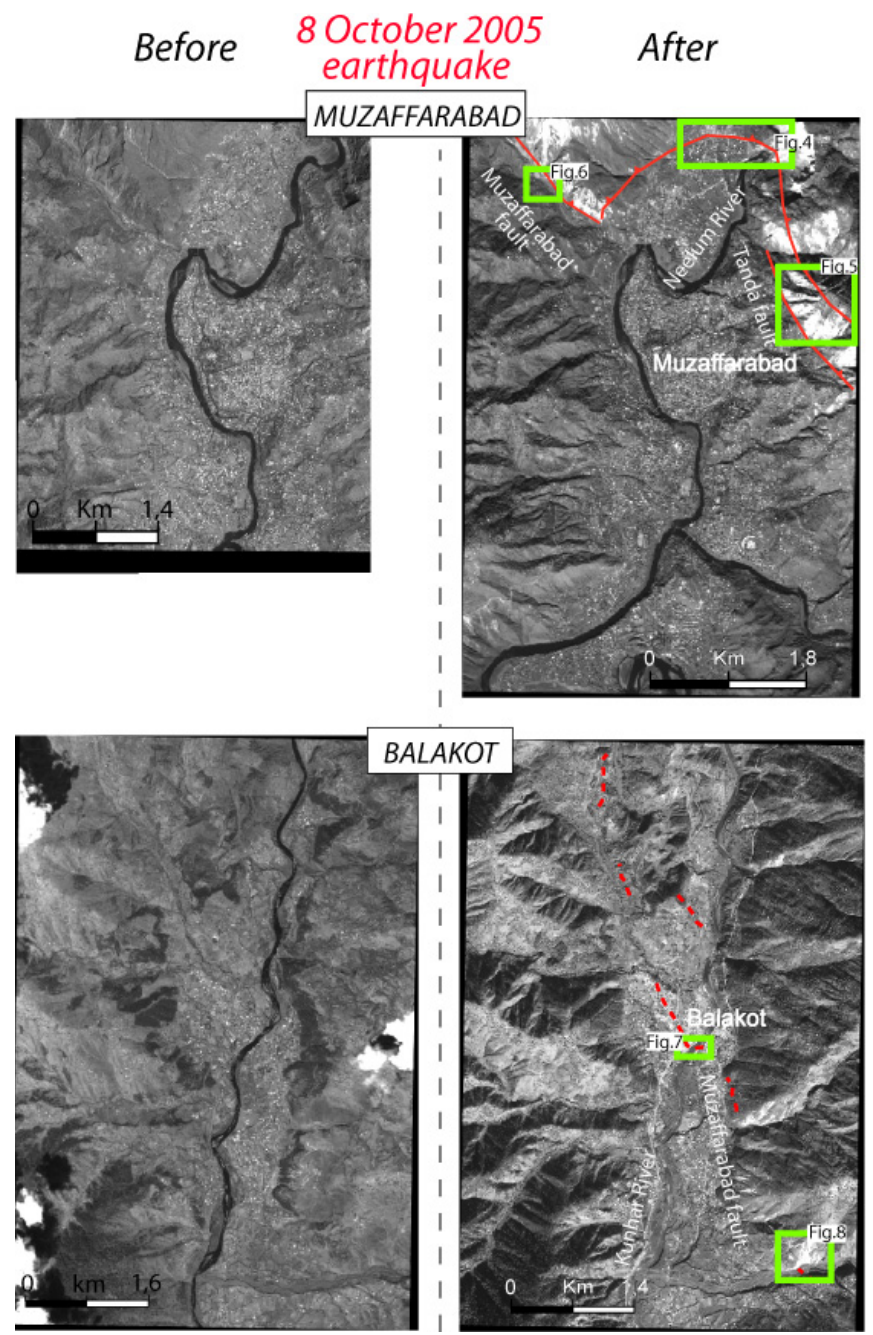
Fig. 2. Quickbird images acquired before and after the 8 October 2005 earthquake for both areas of Muzaffarabad (13 August 2004 and 22 October 2005) and Balakot (11 August 2005 and 19 October 2005). Fault trace is marked with red line, dashed where inferred. The green rectangles include the areas shown in the indicated